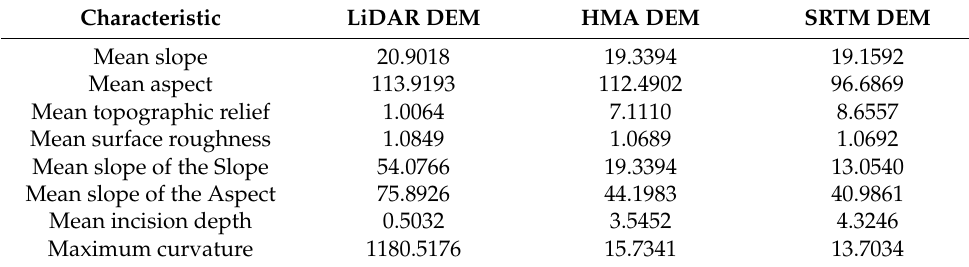
Table 3. Geomorphic characteristic parameters of three kinds of DEM.